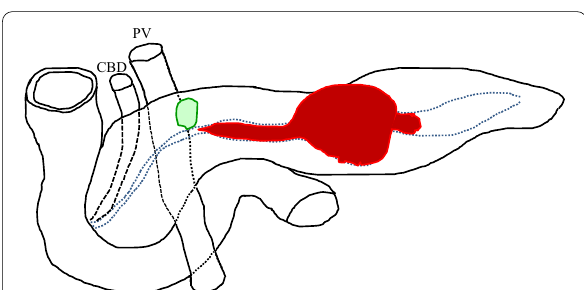
transected at the side of the SMV. The postoperative course was uneventful. We presented adjuvant chemo- therapy with S1, but the patient refused. There has been no relapse for 5 months postoperative follow-up.